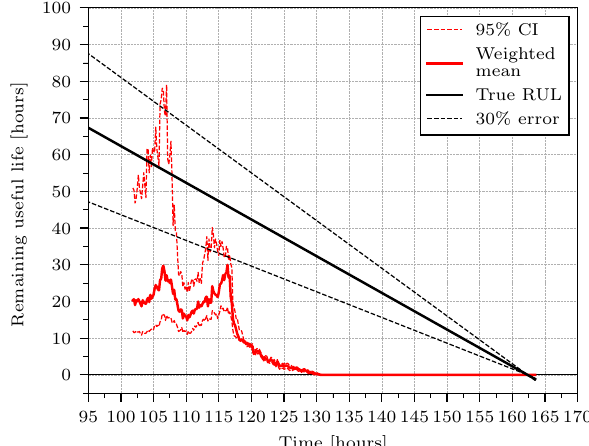
Figure 14: Estimated RUL of the IMS dataset using PF on MD-based HI. The weighted mean, 95% CI, true RUL and 30% error margins are